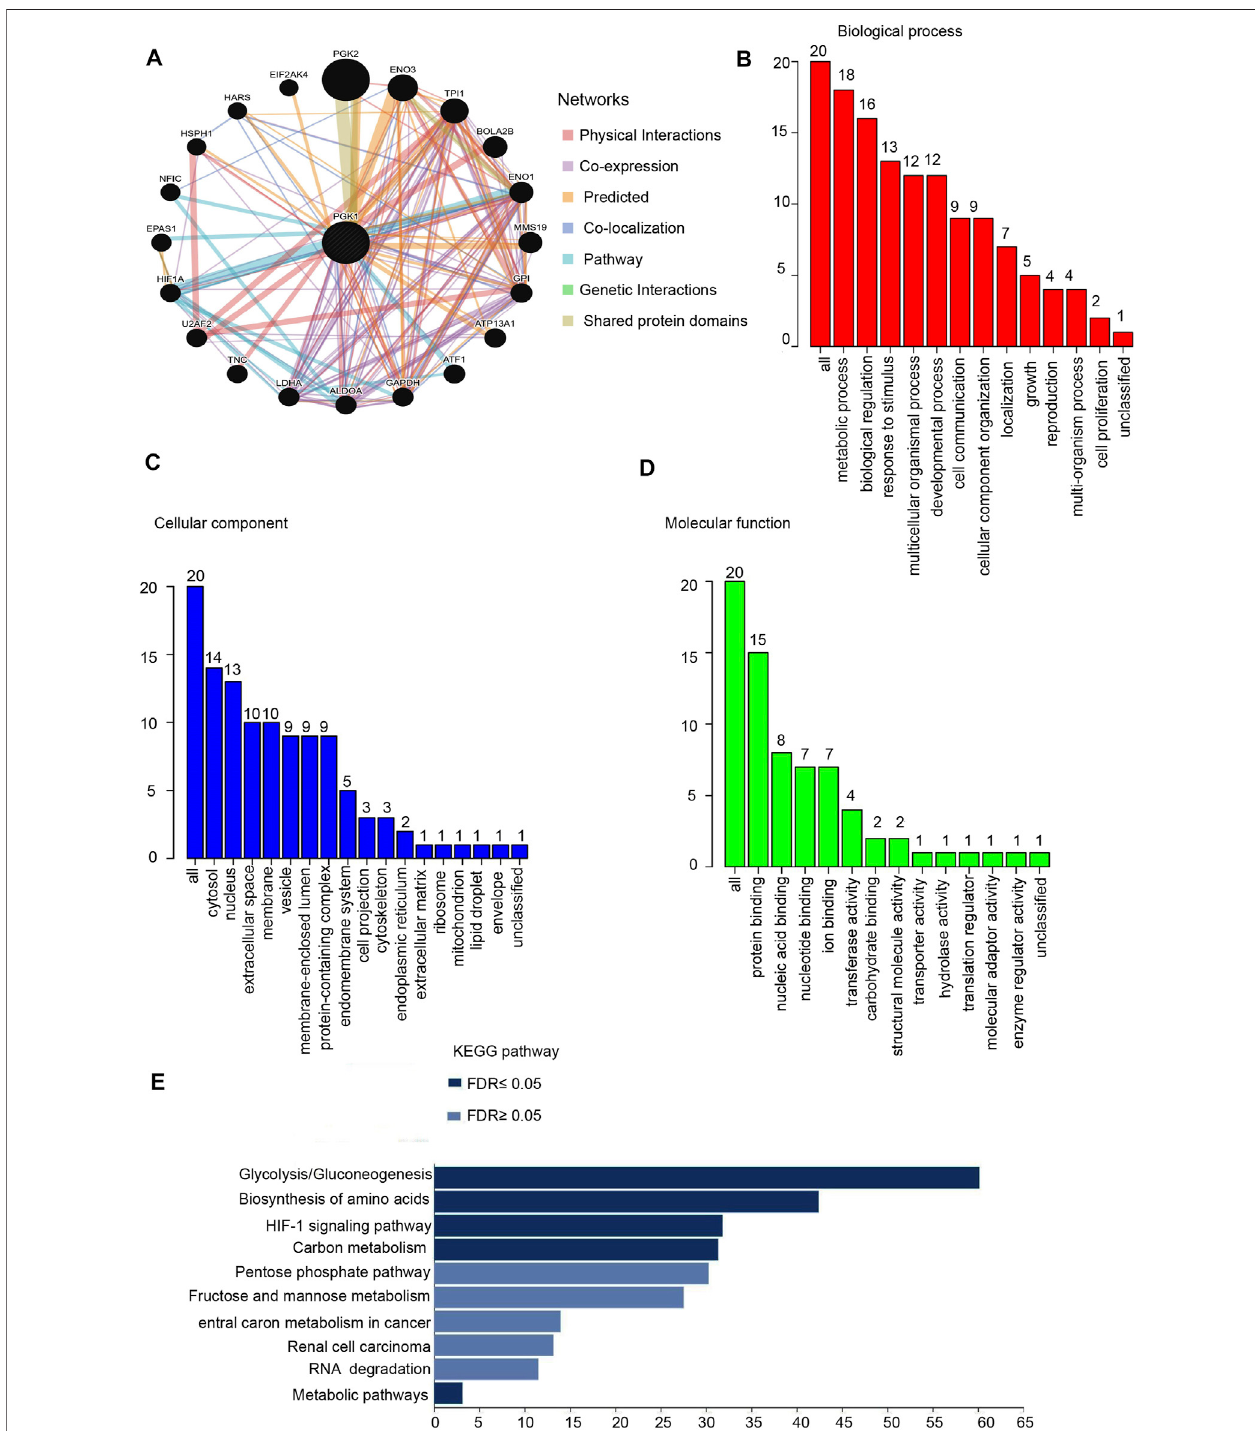
FIGURE 7 | Protein-protein interaction network and function enrichment analysis of PGK1 in breast cancer. (A) Protein-protein interaction network of PGK1 was analyzed by GeneMANIA and Screening for 20 genes interacting with PGK. Different colors of the network edge indicate the bioinformatics methods applied: Physical Interactions, Co-expression, Predicted, Co-localization, Pathway, Genetic Interactions, Shared protein domains. (B) Gene Ontology (GO) is analyzed and the screened 20 gene of BP (Biological Process) is shown. (C) CC (Cellular Component). (D) MF (Molecular Function). (E) KEGG pathways is analyzed the 20 genes co- expressedwithPGK1andtheToppathwayismappedaccordingtothedifferentialexpressionlevelofPGK1( p ≤ 0.05). Y -axis:nameofthesignalingpathwayorfunction; X -axis: percentage of the number of genes assigned to a term among the total number of genes annotated in the network.